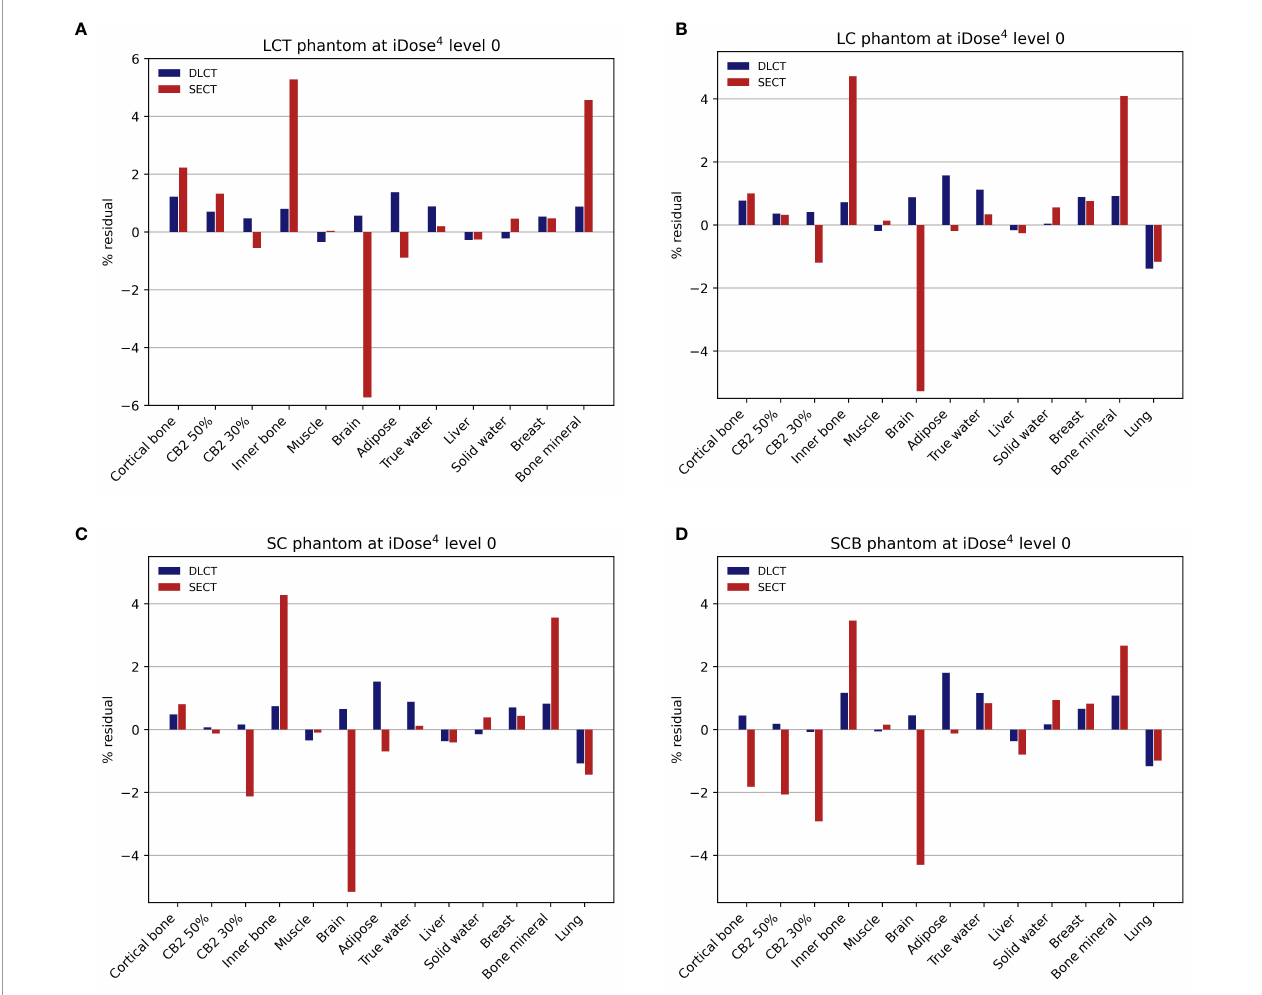
FIGURE 3 | Relative residuals for DLCT- and SECT-based SPR predictions compared to reference values. (A) LCT ( “ long cylinder thin ” ) phantom, (B) LC ( “ long cylinder ” ) phantom, (C) SC ( “ short cylinder ” ) phantom, and (D) SCB ( “ short cylinder big ” ) phantom. The measurement of the LCT phantom was performed without the lung insert, as the lung insert did not fi t into the LCT phantom due to its slightly larger diameter. Note the different scaling of the y-axis in (A)